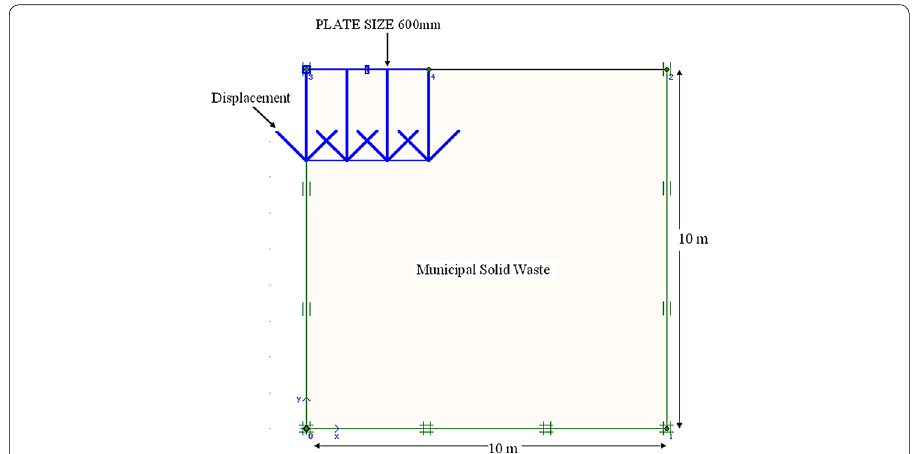
Fig. 17 Model with applied displacement